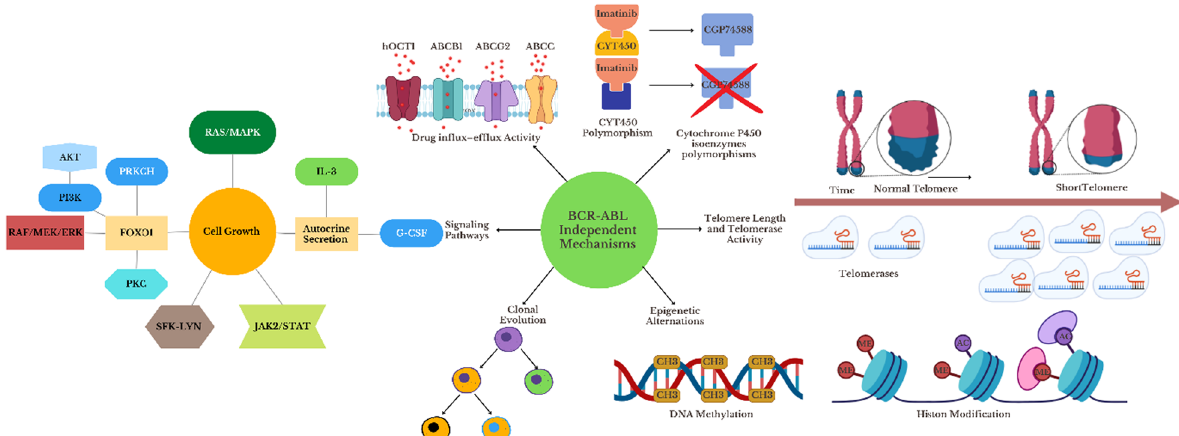
Fig. 3 BCR-ABL-independent mechanisms, a number of mechanisms contribute to this process, such as signaling pathways leading to cell growth, changes in the activity of ABC and other transporters, clonal evolution, polymorphisms of cytochrome p450 isoenzymes, changes in telomere length and telomerase activity, and epigenetic changes. Abbreviations PI3K, phosphoinositide 3-kinase; Akt, protein kinase B, also known as Ak strain transforming (Akt); Ras, rat sarcoma virus; MAPK, mitogen-activated protein kinase; Jak2, janus kinase 2; STAT, signal transducer and activator of transcription; G-CSF, granulocyte colony-stimulating factor; PKC, protein kinase C; SFK, Src family kinase-LYN; IL-3, interleukin 3; CH3 and ME, methyl group; AC, acetyl group FOXO1, forkhead Box O1; PRKCH, protein kinase C eta protein; hOCT1, human organic cation transporter 1;